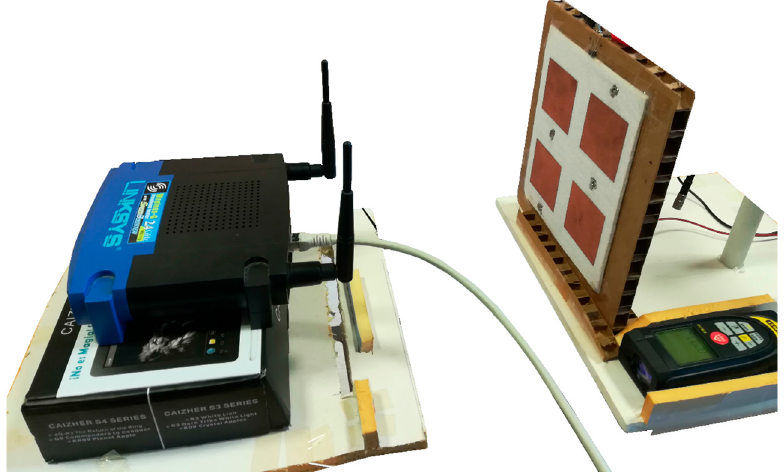
Figure 19. WiFi access point measurement.